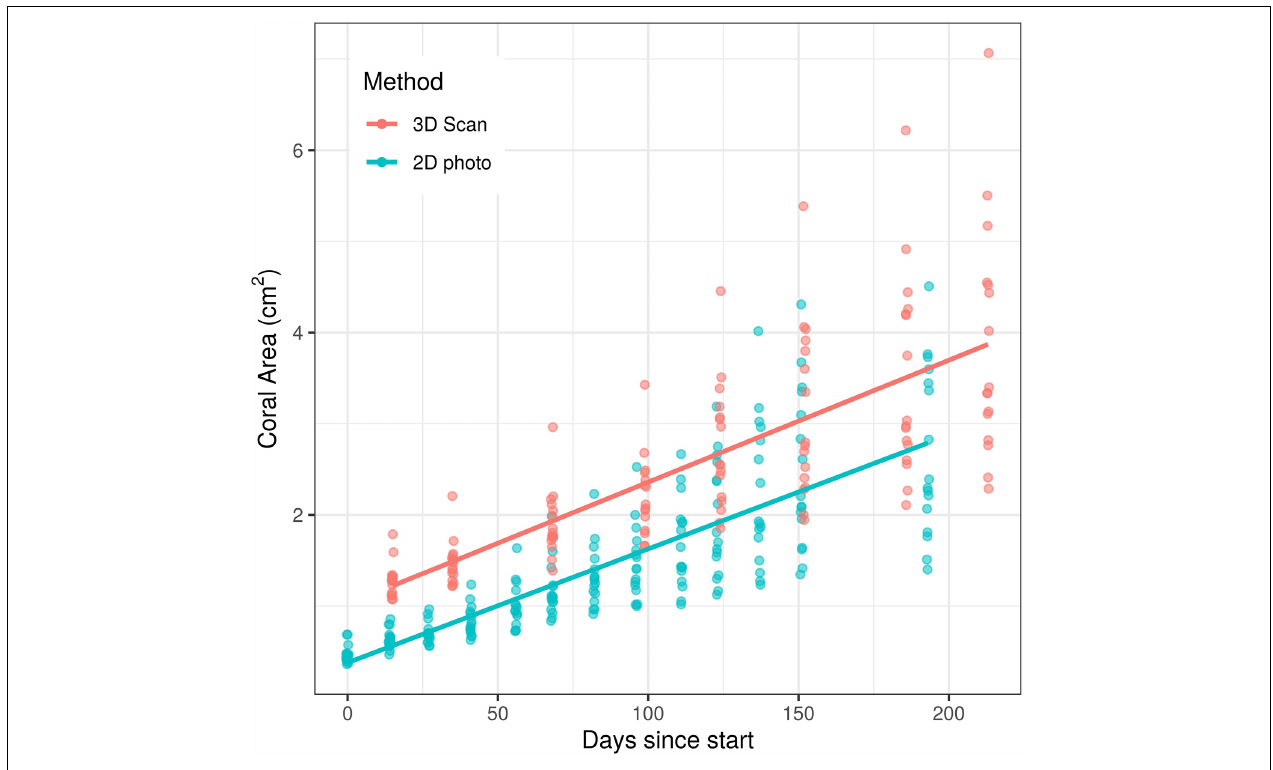
FIGURE 2 | Effects of time and measurement method on coral area measurements over a c.a. 200 day growth experiment. There was a significant effect of both time ( p < 0.0001) and measurement method ( p < 0.0001) on surface area measured, but the effect of measurement method did not change over time ( p =